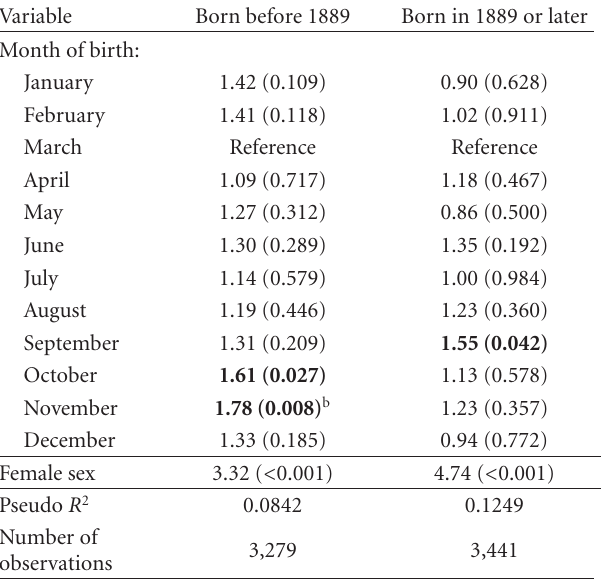
Table 6: Odds ratios ( P values) to become a centenarian as pre- dicted by conditional logistic regression (fixed e ff ects), by di ff erent birth cohort subgroups for siblings survived to age 50. E ff ects of month of birth a .